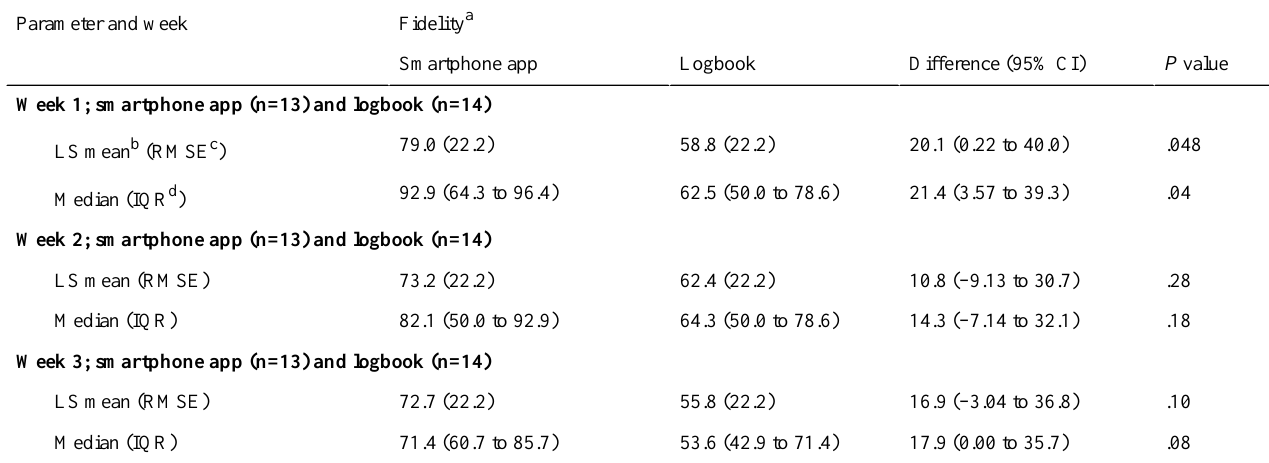
Table 5. Comparison of home blood pressure recording fidelity in the elderly subgroup (60 ≤ age<70).